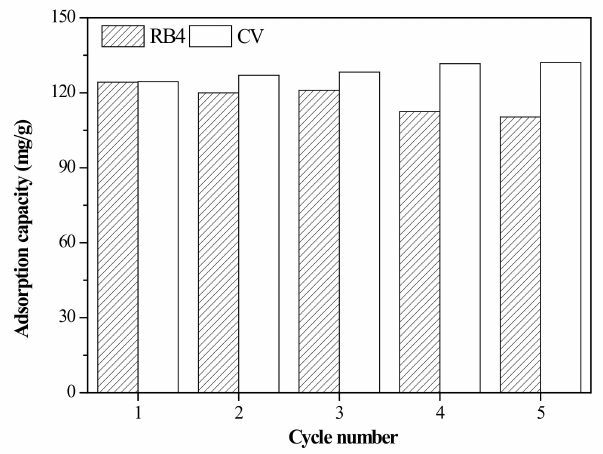
Figure 10. Regeneration performance of rice bran / SnO 2 / Fe 3 O 4